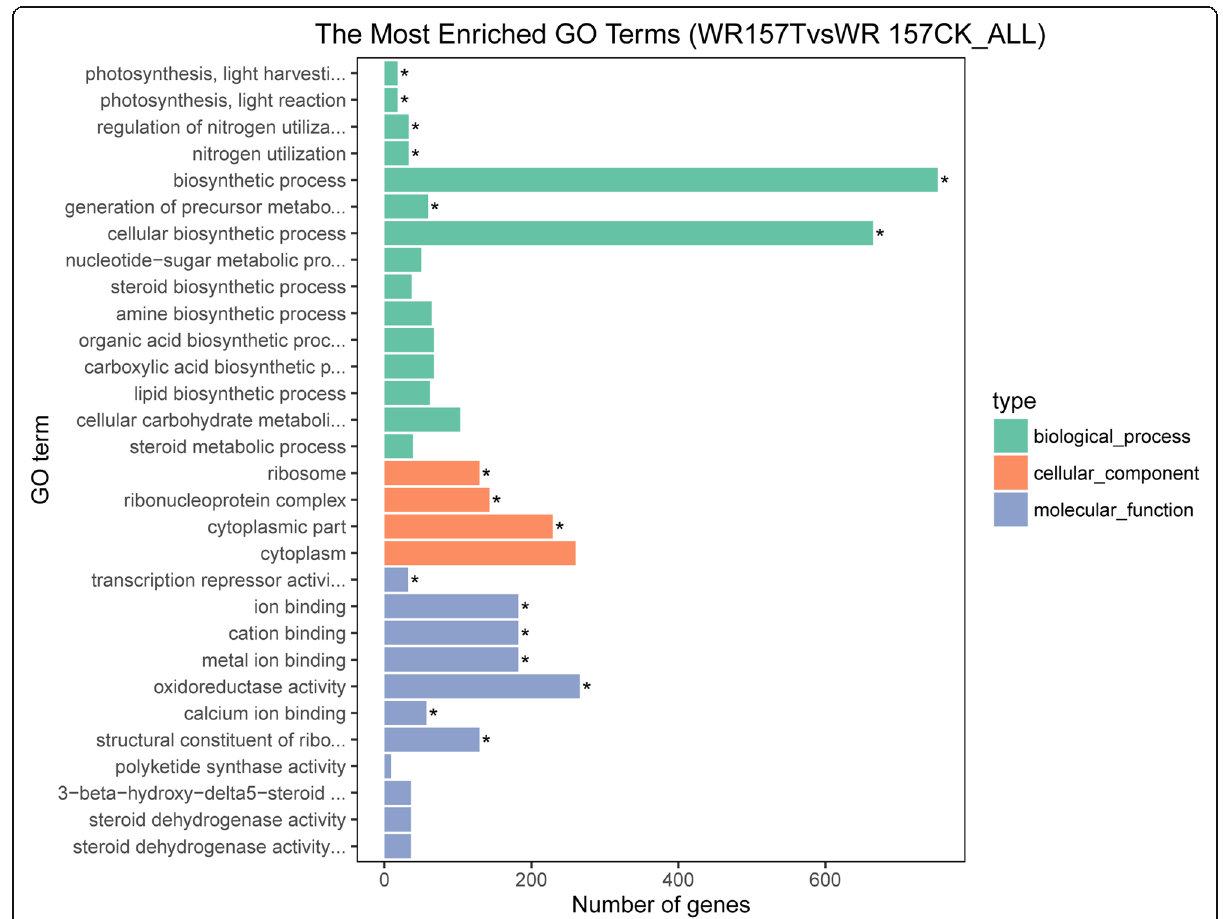
Fig. 5 GO enriched term analysis of differentially expressed genes (DEGs). The asterisks represent significantly enriched GO terms. The histogram (green color) represents the DEGs enriched in biological processes, the orange color histogram represents the DEGs enriched in cellular components, and the blue color histogram represents the DEGs enriched in molecular